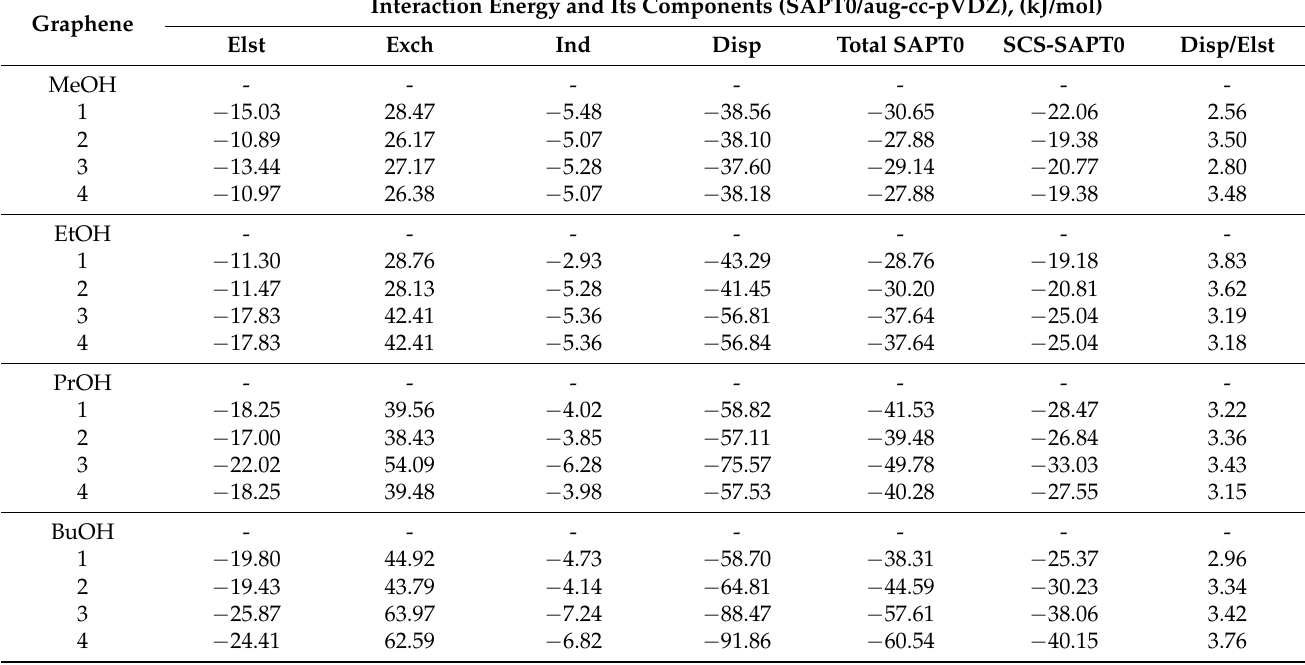
Table 1. The components of Equation (2) for studied